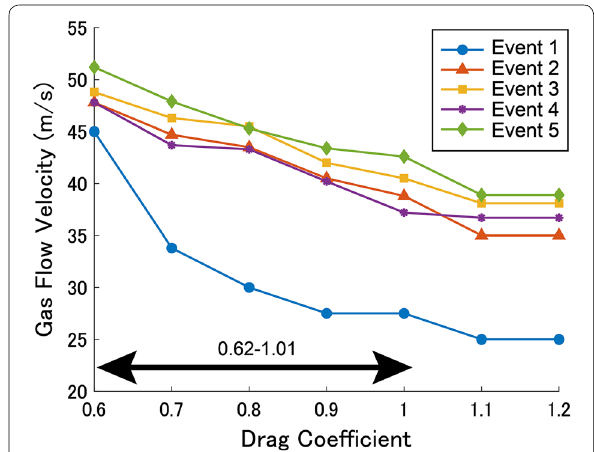
Fig. 6 Estimated gas flow velocities. The drag coefficient values range from 0.62 to 1.01 and represent the measured drag coefficient based on experiments that were conducted with the ballistic projectiles of Popocatépetl volcano (Alatorre-Ibargüengoitia and DelgadoGranados 2006)